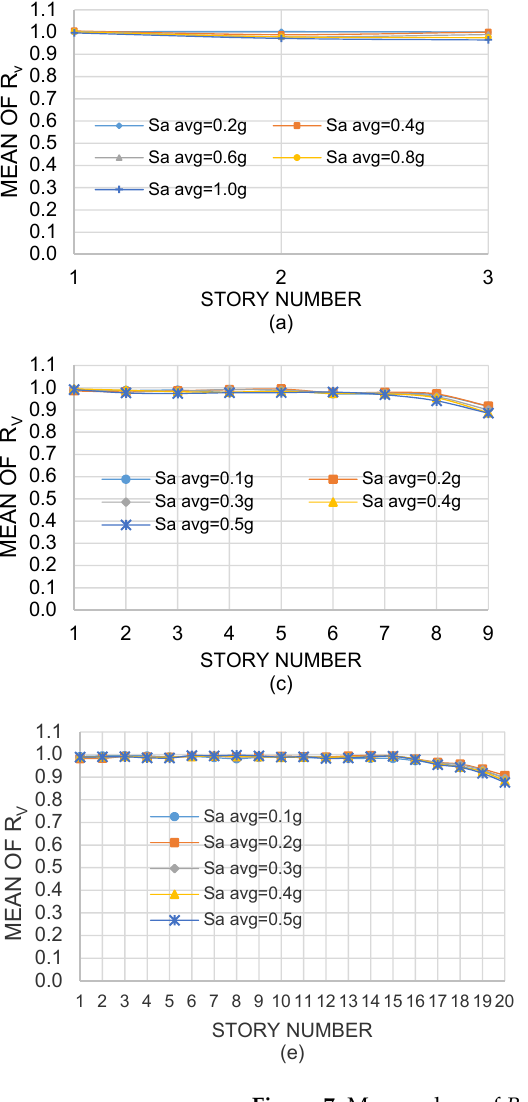
Figure 7. Mean values of R V ; ( a , b ), NS - EW direction, respectively, Model 1; ( c , d ), NS - EW direction, respectively, Model 2; ( e , f ), NS - EW direction, respectively, Model 3.